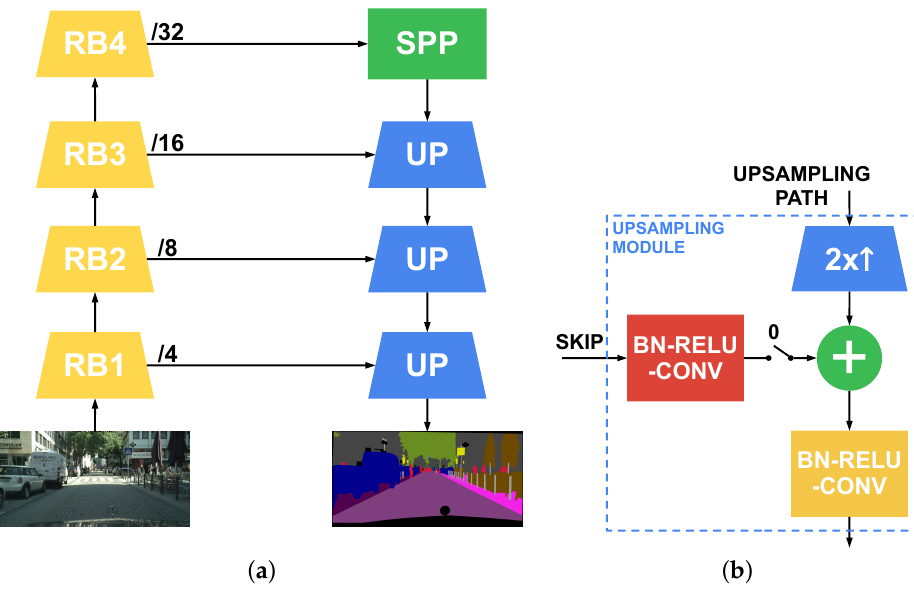
Figure 1. ( a ) SwiftNet model for semantic segmentation based on ladder-style architecture. ( b ) Closer look at the SwiftNet upsampling module which fuses skip connections with the main features from the upsampling path via element-wise